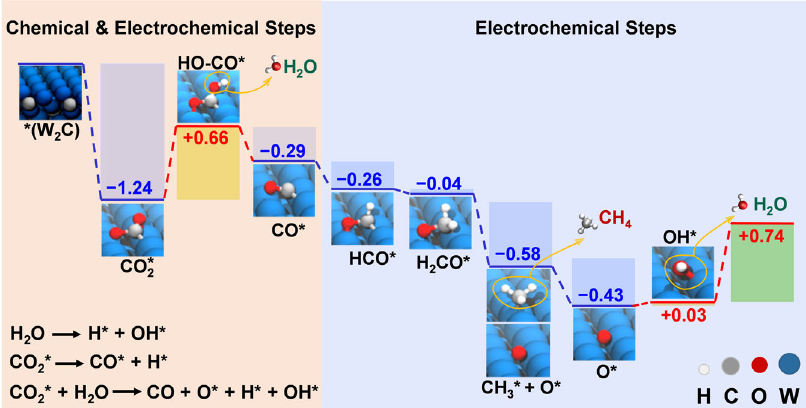
Fig. 3 Minimum energy path for the electrochemical CO 2 conversion into CH 4 on the surface of W 2 C NFs. Only electrochemical steps are shown. The parts of the reaction where chemical and electrochemical steps are essential are highlighted by colors. The favorable reactions of key chemical steps are provided (for free energies of these reactions, see Table S9). The intermediates are indicated. Gibbs free energies for reaction at zero potential vs RHE are given